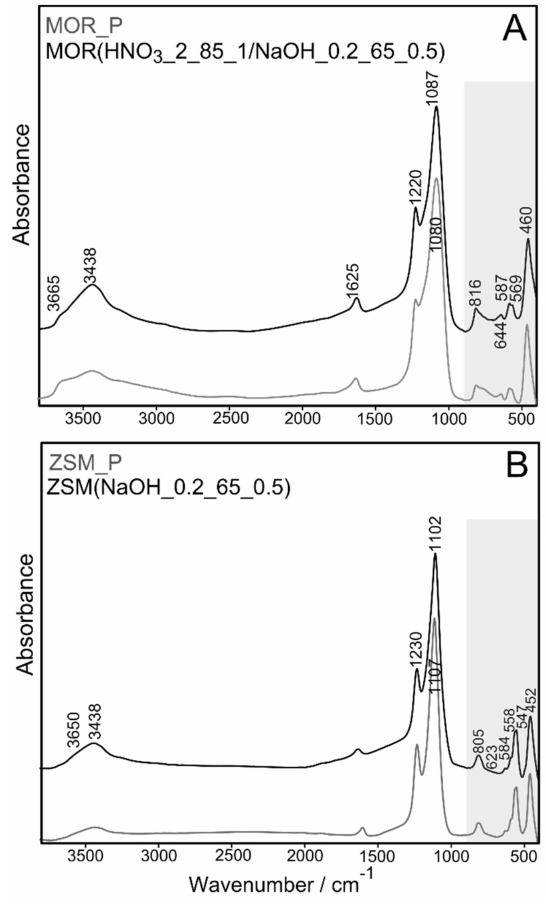
Figure 5. Mid-infrared (MIR) spectra of parent MOR_P and